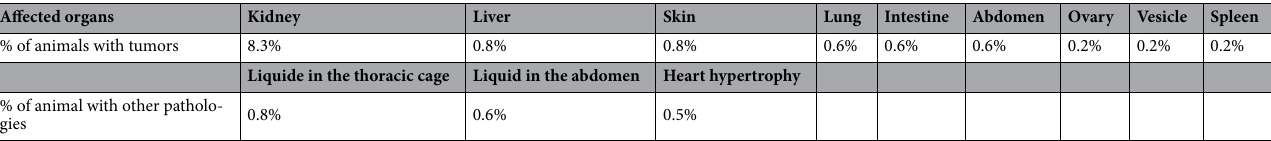
Table 1. Statistic of pathologies reported after animal euthanasia (N GML =